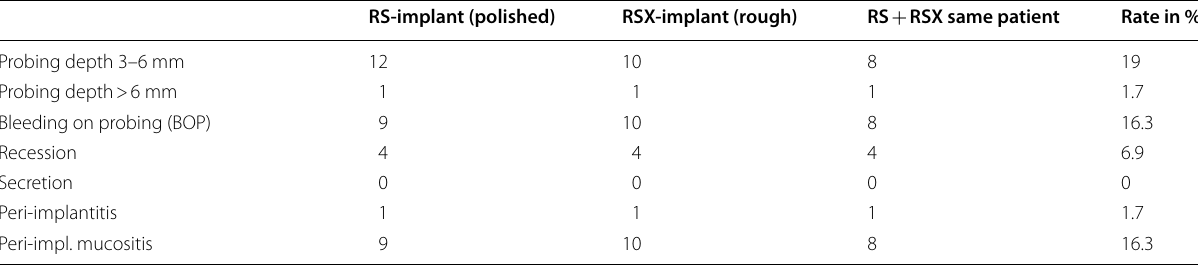
Table 1 Clinical criteria for peri-implant soft tissue health after 2 years including probing depth, bleeding on probing, recession, secretion, peri-implantitis and peri-implant mucositis separated for polished shoulder implants (RS-line implants), rough shoulder Implants (RSX-line implants) and both in the same patient RS‑implant (polished) RSX‑implant (rough)